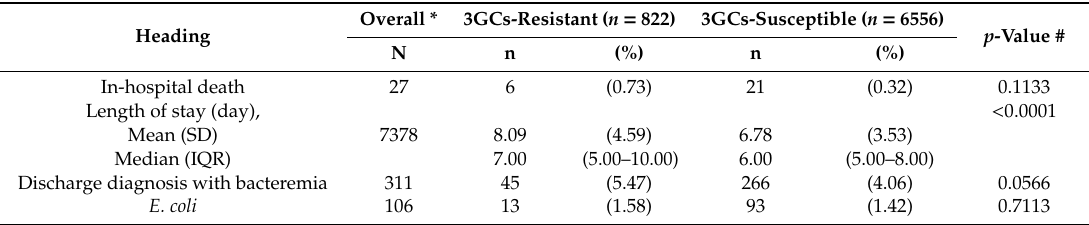
Table 1. Healthcare service use and patient outcomes among children with community-associated E. coli urinary tract